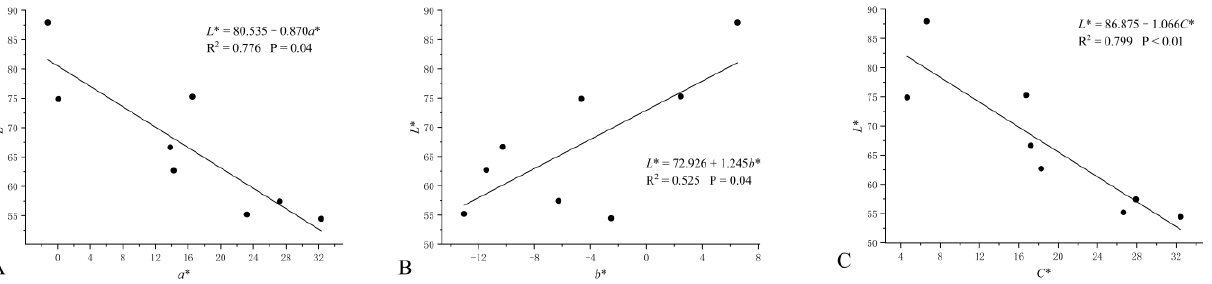
Figure 3. The linear regression between L * and a * ( A ), b * ( B ), C * ( C ) of eight cultivars of Hibiscus syriacus. Each solid circle in each panel was the mean value of five replicates of each cultivar of Hibiscus syriacus .